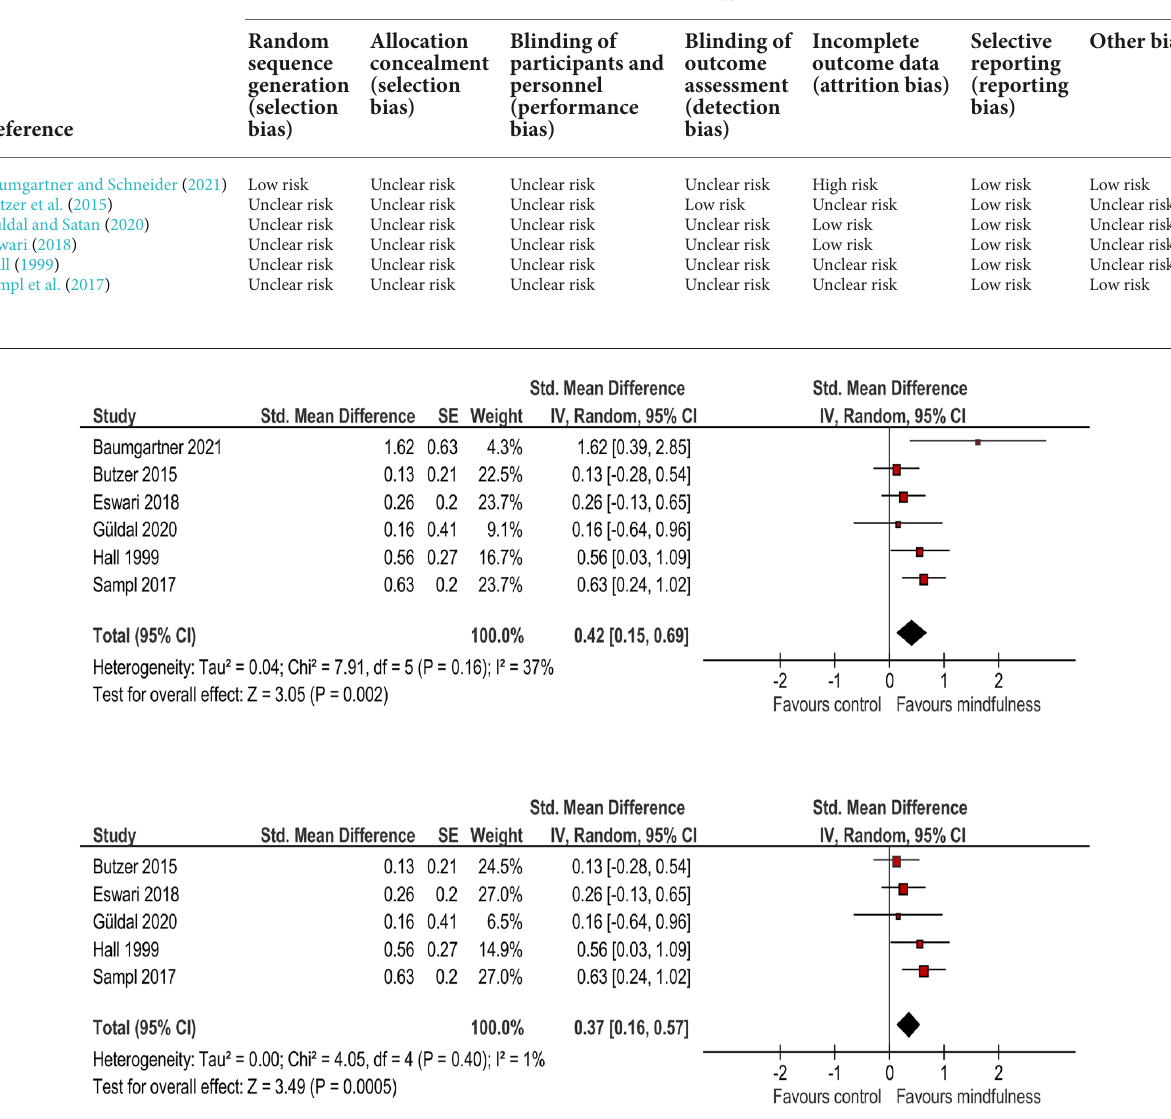
FIGURE2 Analysis of overall effect (above) using the complete sample (above) and excluding an outlier